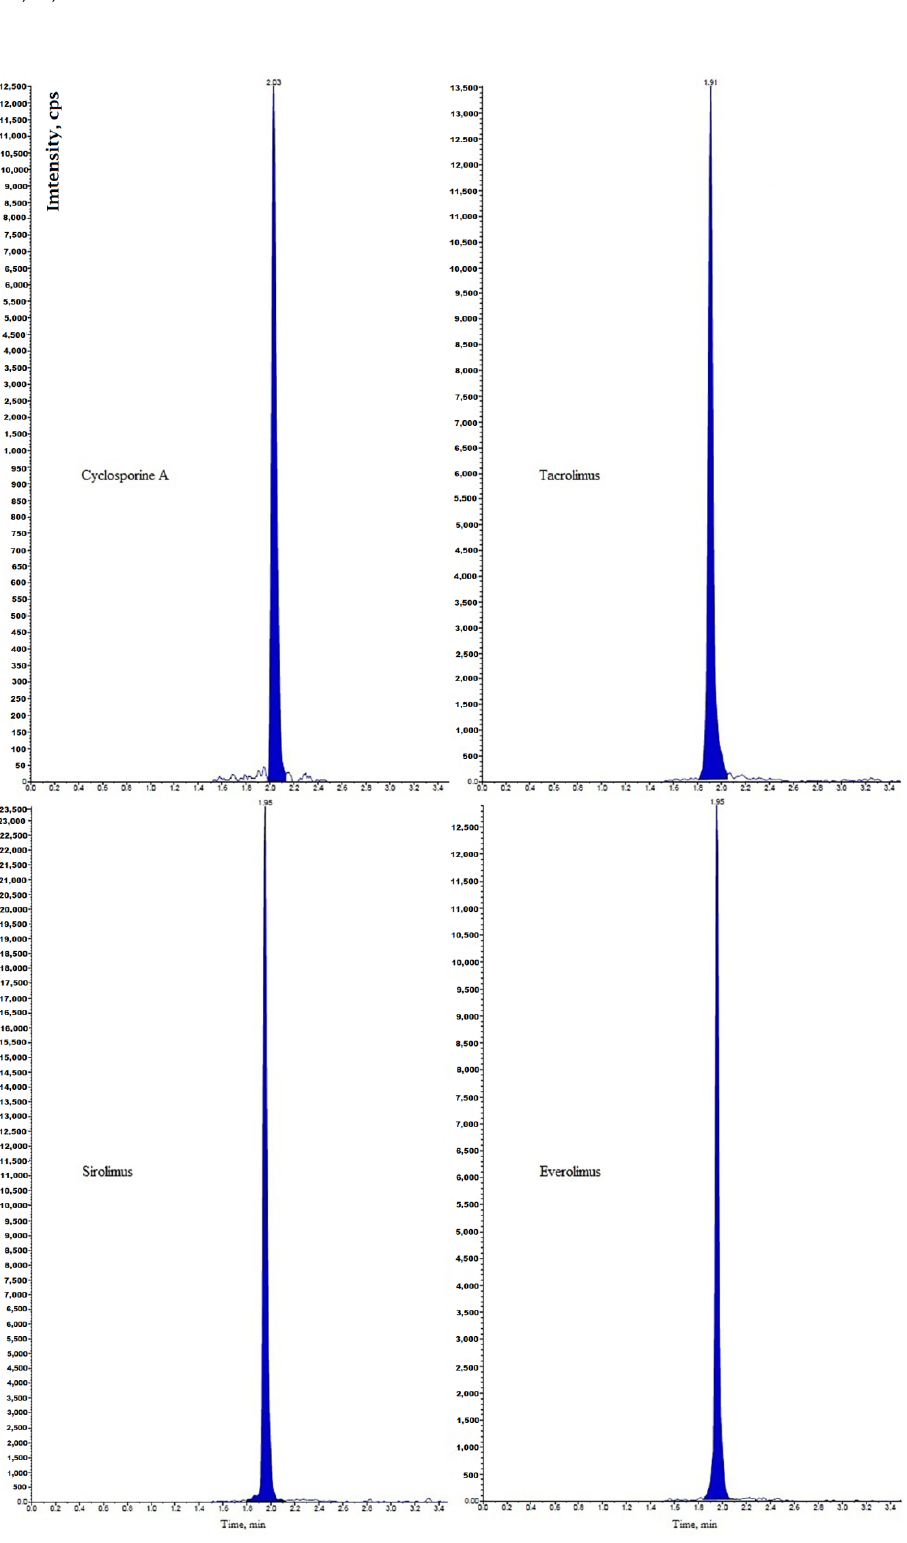
Figure 1. Multiple reaction monitoring (MRM) chromatograms of the immunosuppressants: cyclosporine A (CsA), Tacrolimus (TcR), Sirolimus (SiR), and Everolimus (EvE) in the whole blood of four patients taking different immunosuppressive drugs. The measured concentration was 42.2 for CsA, 6.5 for TrC, 11.1 for SiR, and 7.0 ng mL −1 for EvE [15]. Automation of the often time-consuming sample preparation process prior to chromatographic analysis was increasingly used for the pretreatment of biological samples